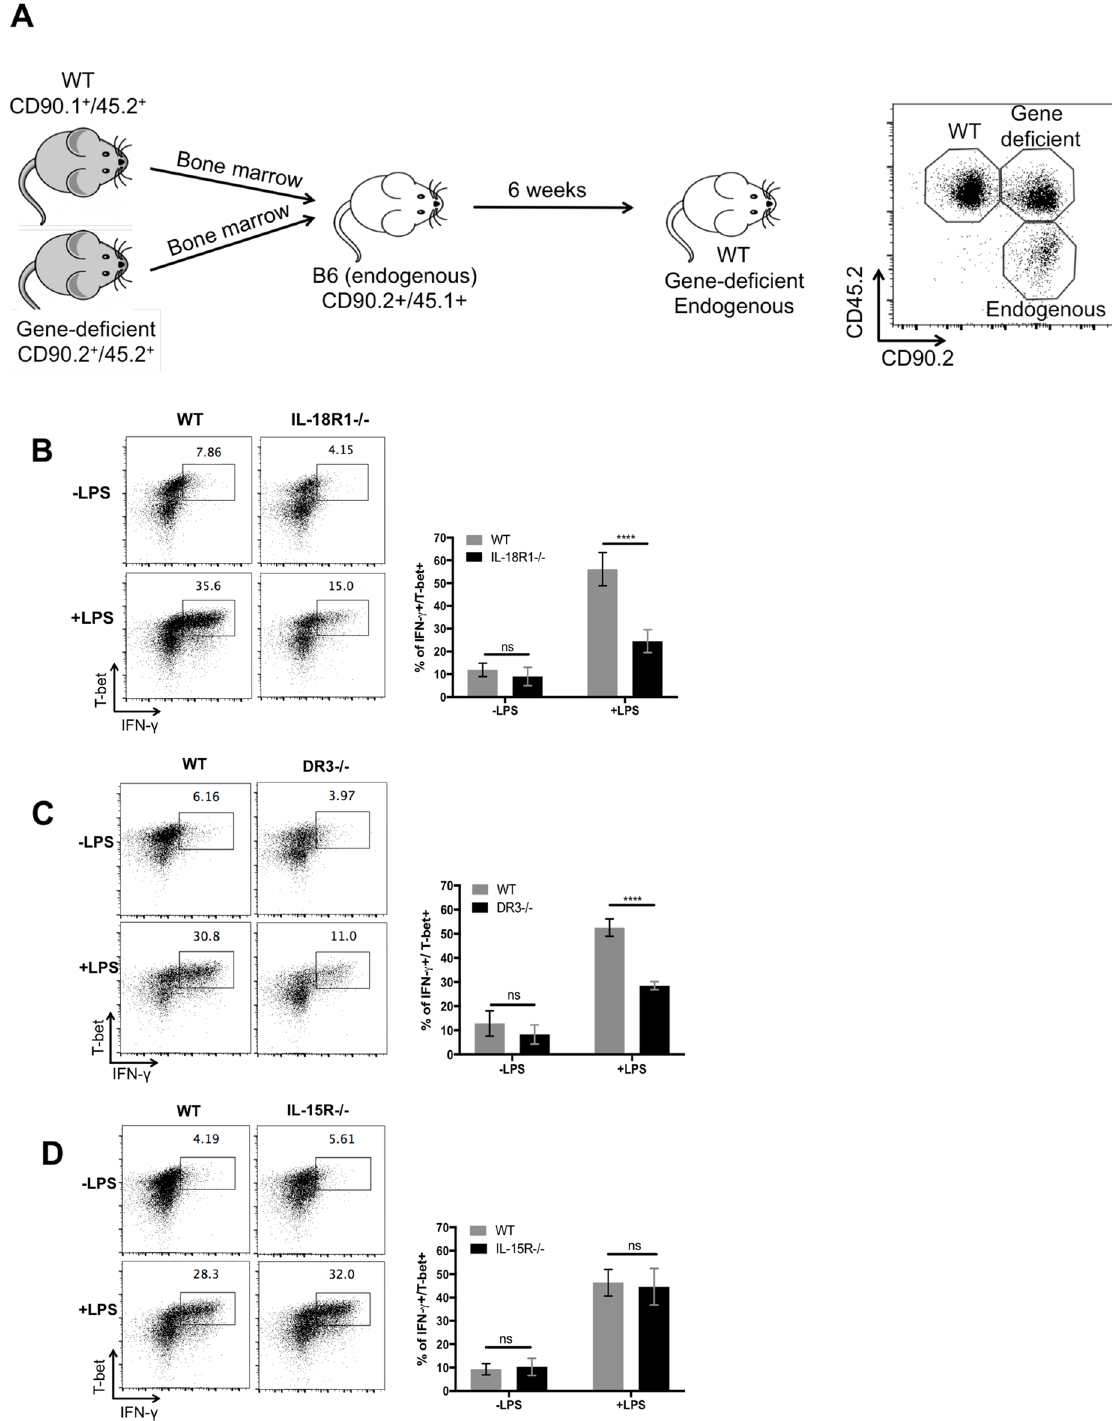
Fig 4. IL-18R and DR3 are required for optimal IFN- γ production. BM chimeras were infected with 5 × 10 5 Salmonella Typhimurium followedby LPS injectiontwo weeks after that. Spleenswere collected4 hours later to determine IFN- γ production by T-bet+ cells. (A) CD45.1+ recipients were irradiatedand reconstituted with a mixture of bone marrow (BM) from wild-type (WT) (CD90.1+CD45.2+) and geneticallydeficientdonors (CD90.2+CD45.2+). After immune reconstitution, WT and gene-deficient cells were distinguished within BM chimeras by congenic markers CD45.2 and CD90.2as shown in representative flow plot. (B) Representative flow cytometry plots and a graph of combineddata are shown for IL-18R-deficient- (B), or DR3-deficient- (C), or